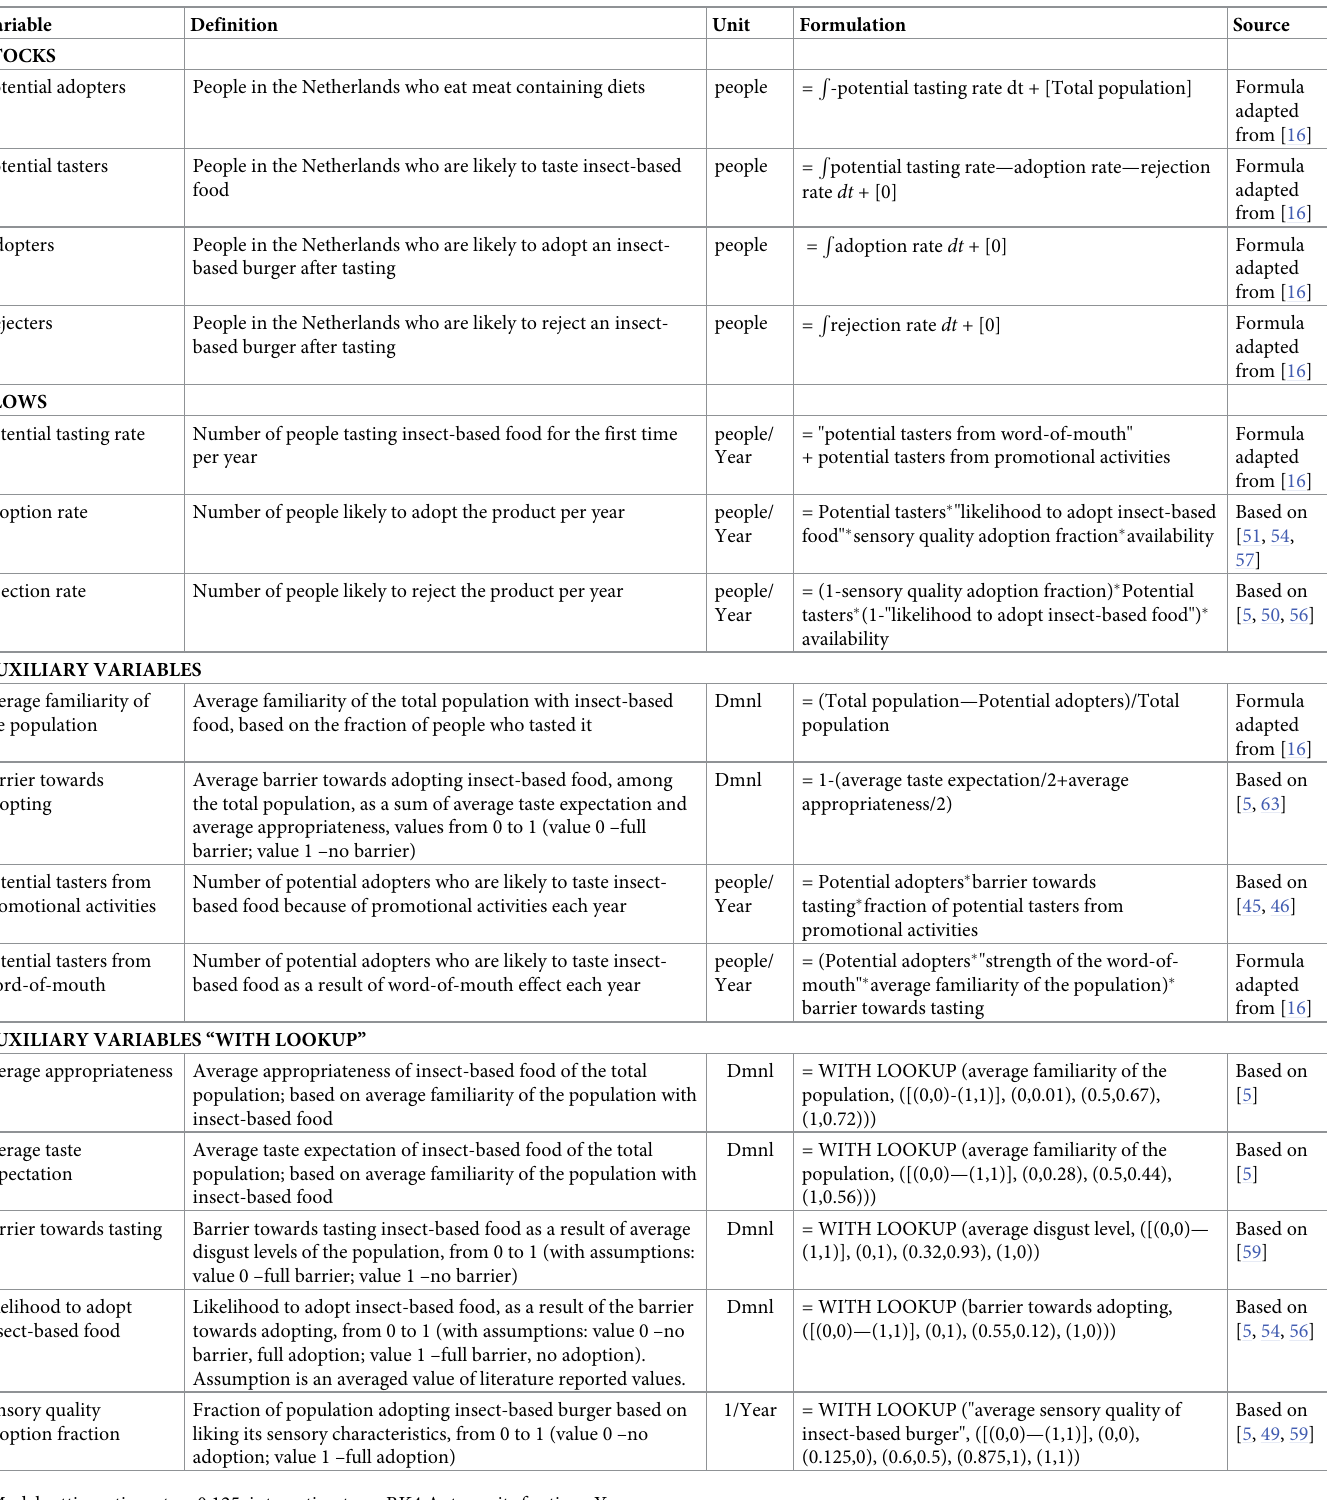
Table 1. Stock, flow and auxiliary variables of the insect-based food adoption model–Vensim formulations and assumptions with sources �